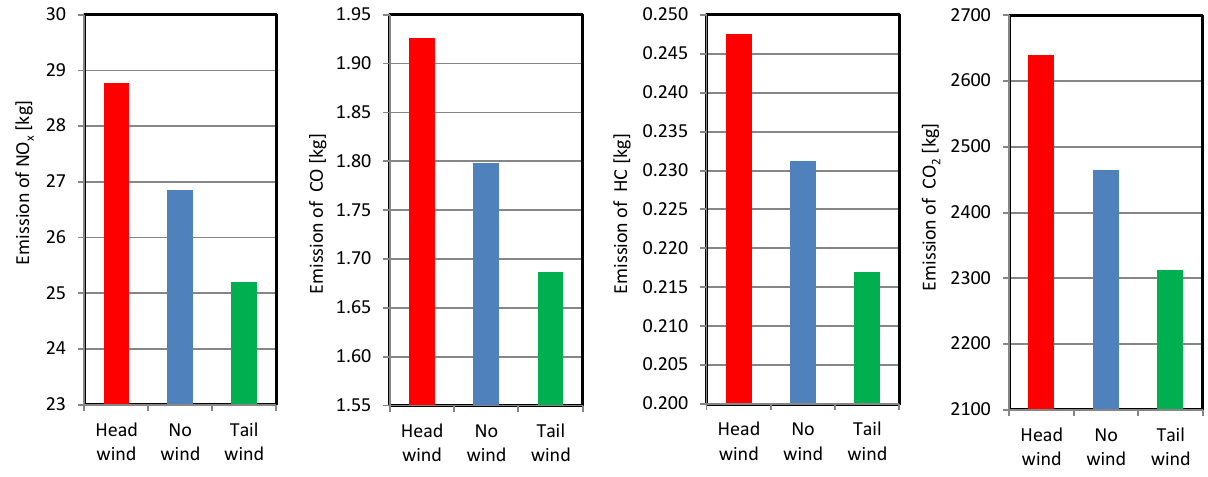
Fig. 4. Total emission of NO x , CO, HC and CO 2 in the exhausts of Gulfstream IV in each scenario of the